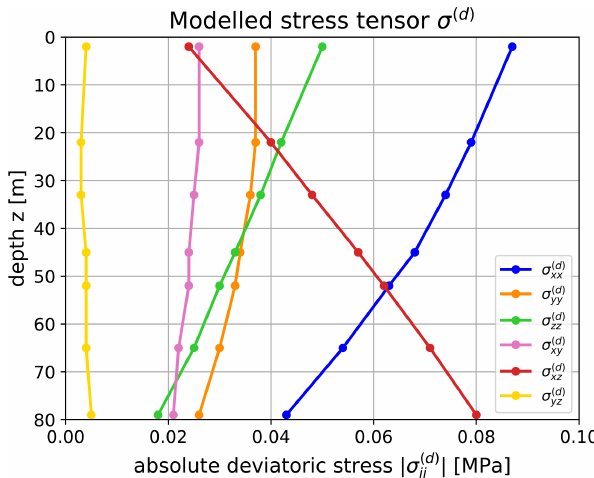
Figure 7. Absolute values of the deviatoric stress tensor elements obtained from ice flow modelling ( x – longitudinal, y – transverse, z – vertical